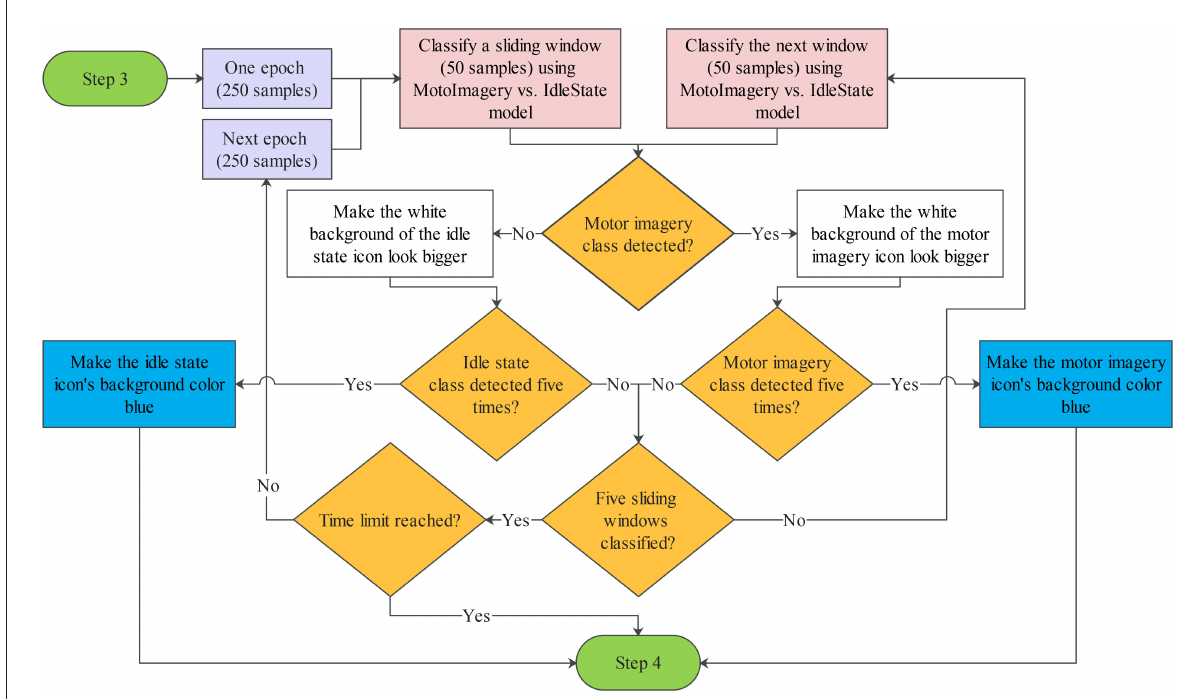
FIGURE4 Flowchart of the online classification. In online conditions, the BCI processes each time window of the epoch and assigns it one class between motor imagery and idle state. The BCI also provides continuous visual feedback on the classifications by making the white background of the icon corresponding to the class look bigger or turn blue. The time limit to detect five consecutive times the same class and pass step 3 is 15